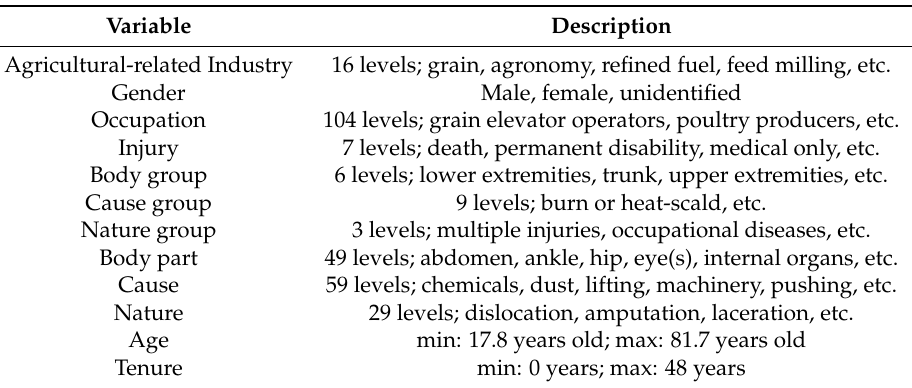
Table 2. Description of predictive